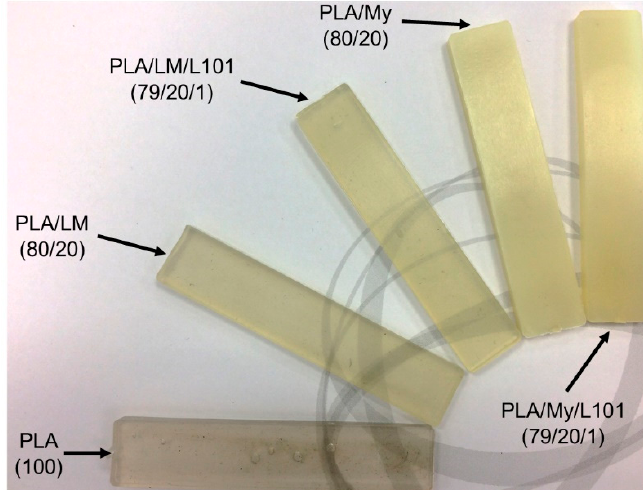
Figure3. Photographofas-processedpolylactide(PLA)-basedmaterialsafterinjectionmoldingshowing Figure 3. Photograph of as-processed polylactide (PLA)-based materials after injection molding that PLA, PLA / limonene (PLA / LM), and PLA / LM / luperox 101 (PLA / LM / L101) were transparent, while showing that PLA, PLA/limonene (PLA/LM), and PLA/LM/luperox 101 (PLA/LM/L101) were PLA / myrcene (PLA / My) and PLA / My / luperox 101 (PLA / My / L101) were opaque (specimen width 11